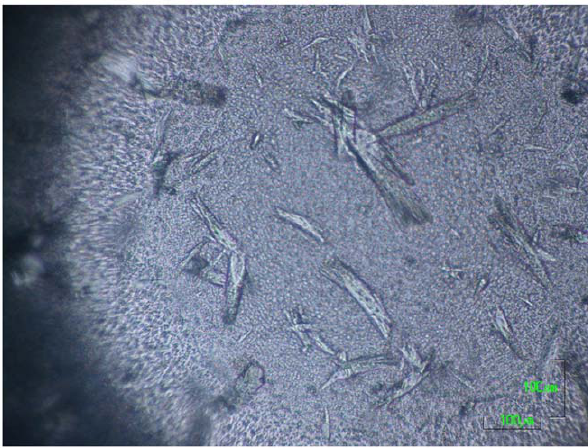
Figure 3. SDS-PAGE of HCP spiking experiment. Silver-staining. Lanes: (1) mAb04c, standard; (2) mother liquor with mAb04c and lysozyme; (3) washed mAb04c crystals from mother liquor with lysozyme; (4) the supernatant from the crystallization with lysozyme; (5) mother liquor with mAb04c and BSA; (6) washed mAb04c crystals from mother liquor with BSA; (7) the supernatant from the crystalliza- tion with BSA.